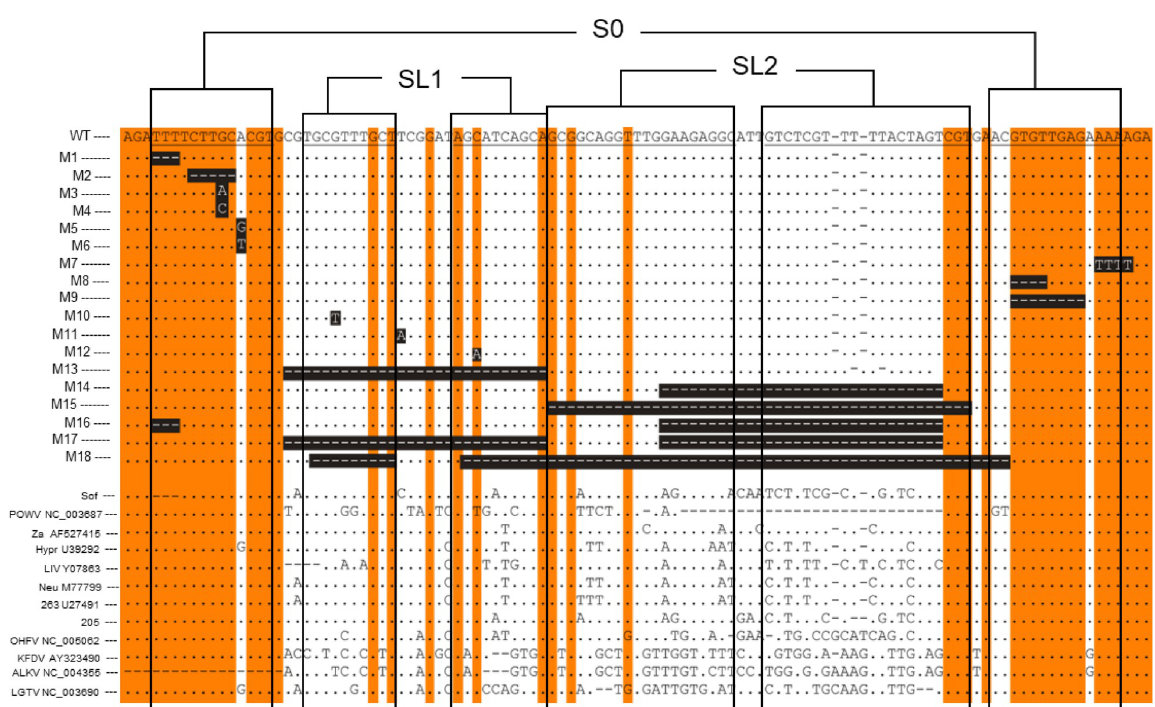
Fig 2. Alignment between the 5 0 UTRs of tick-borne flaviviruses and constructed mutants (M). Accession numbers are indicated. Reference sequences for Sof [44] are shown. The top line depicts Vs virus that was used to produce the infectious clone. Conserved regions are highlighted in orange. Elements of the RNA secondary structures are specified as S0, SL1, and SL2 within SLA. Deletions and substitutions are highlighted in white letters within black boxes. Numbers in front of the 5’UTR mutants correspond to the numbers in Fig